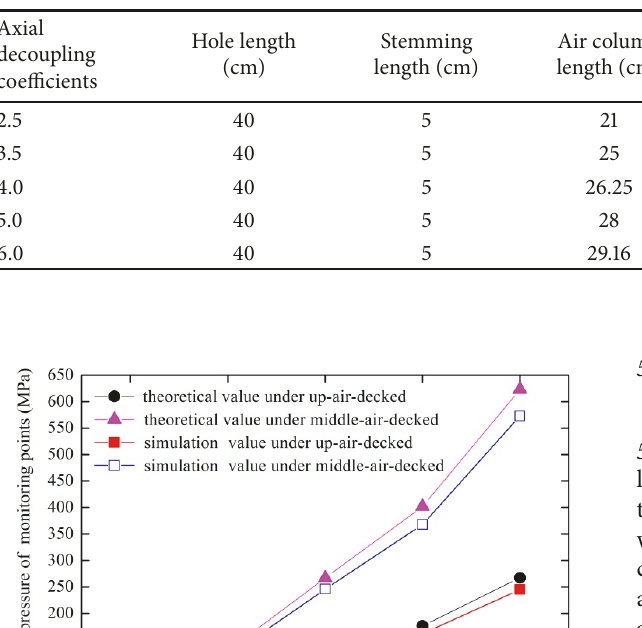
Table 7: The charging parameters.